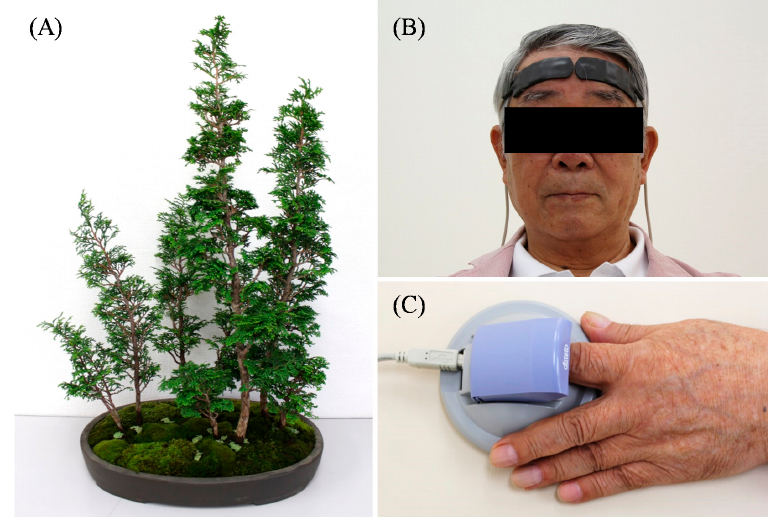
Figure 1. Bonsai trees and physiological measurement apparatuses. ( A ) Japanese cypress bonsai trees; ( B ) Participant undergoing near-infrared spectroscopy (NIRS) measurement; ( C ) Participant undergoing heart rate variability (HRV) measurement.